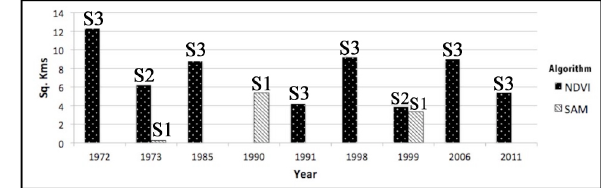
Figure 2: Total area of the mangroves (km 2 ) in Tarut Bay during 9 years in the period 1972 to 2011, as estimated by